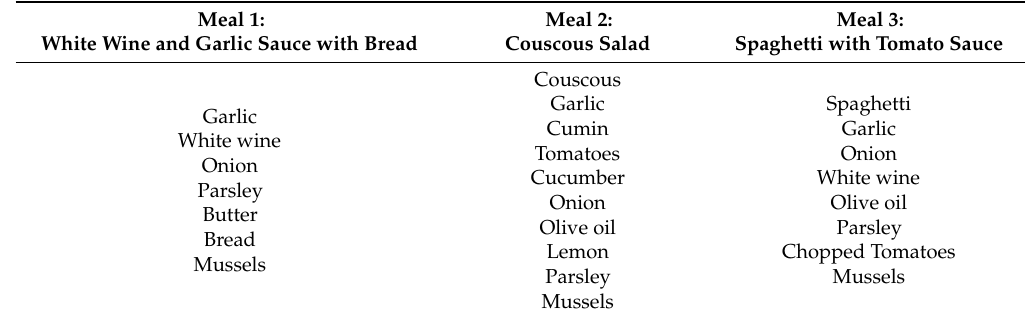
Table 3. Breakdown of ingredients for each meal provided to participants. Meal 1: White Wine and Garlic Sauce with